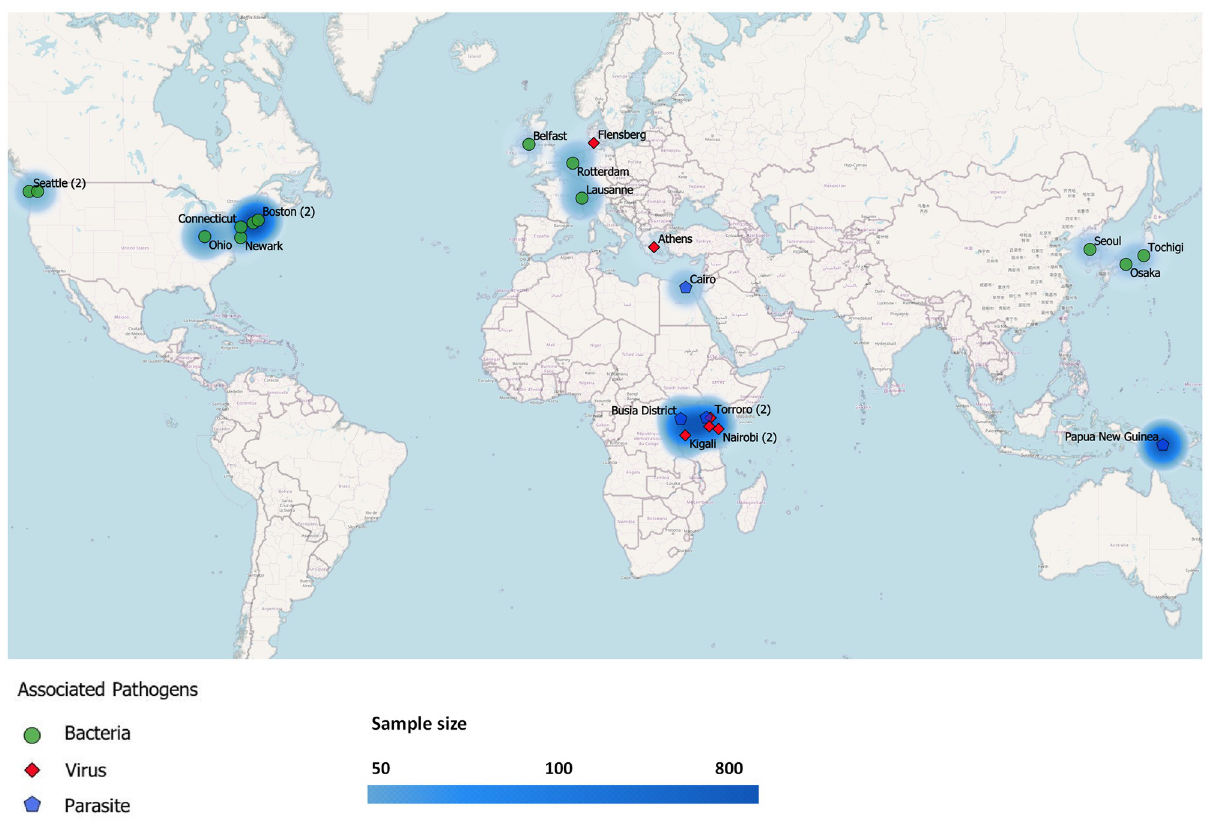
Fig 2. Map of countries where studies were